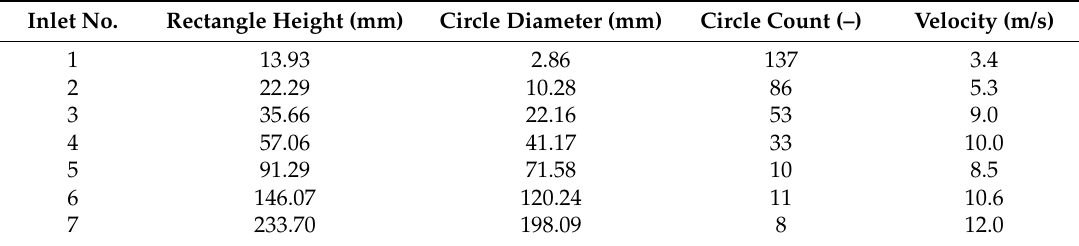
Table 1. Summary of the velocity